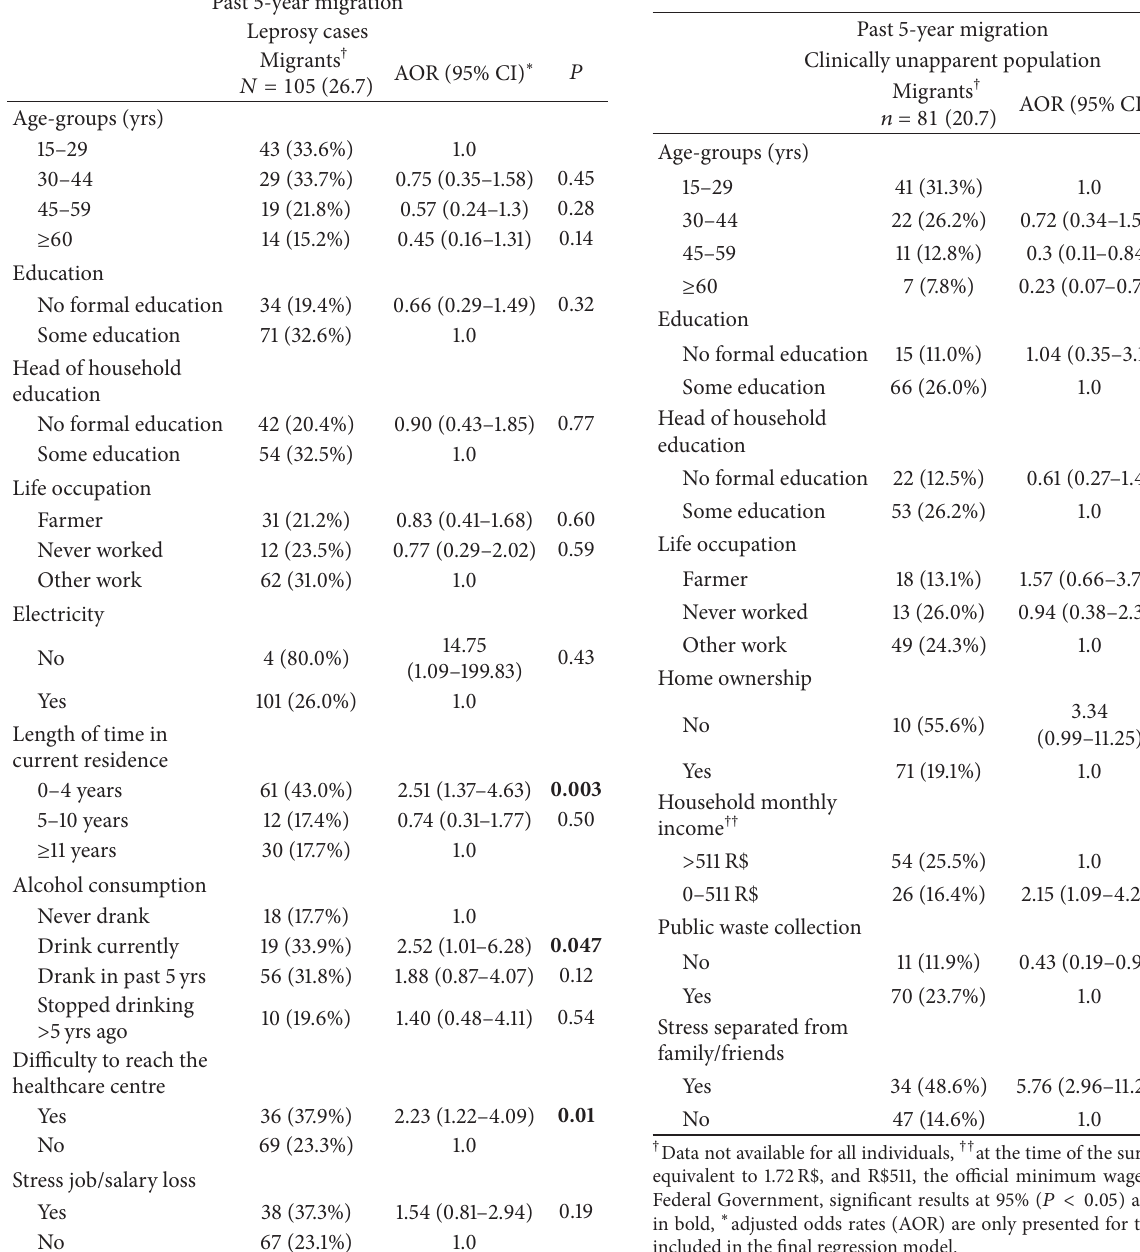
Table 3: Multivariate analysis of factors associated with past 5 year migration among migrants diagnosed with leprosy compared to non-migrant residents with leprosy.